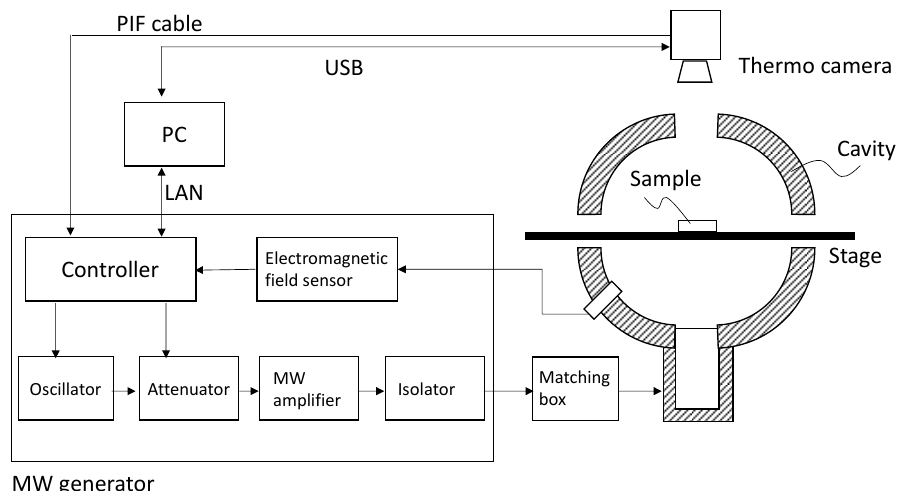
Figure 1. Schematic diagram of the microwave (MW) heating system. PIF: process interface; USB: universal serial bus; LAN: local area network.